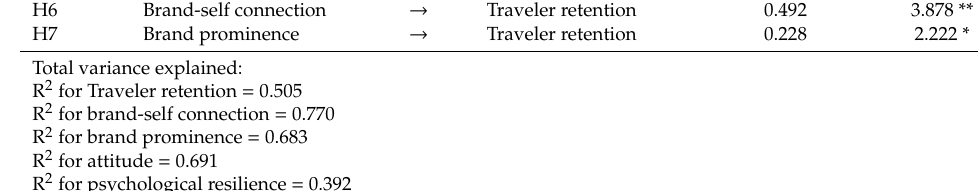
Total variance explained: R 2 for Traveler retention =